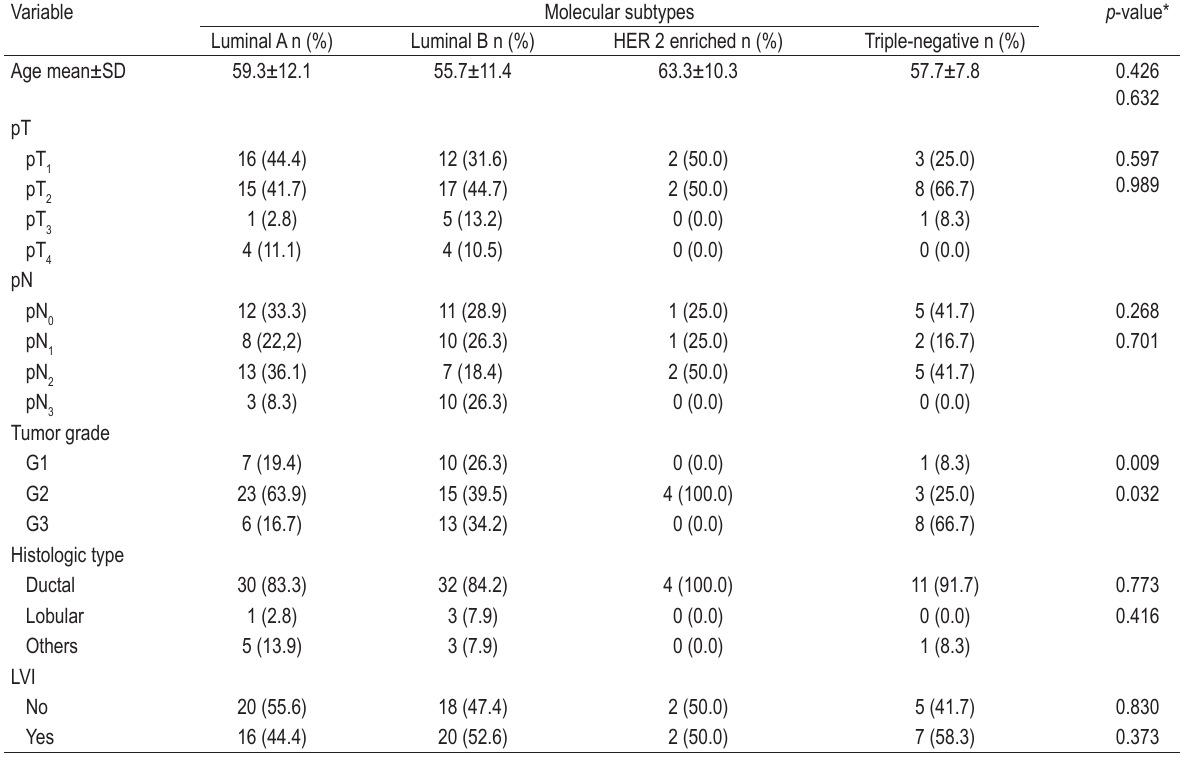
TABLE 2. Clinicopathologic characteristics of molecular subtypes of breast cancer Variable Molecular subtypes